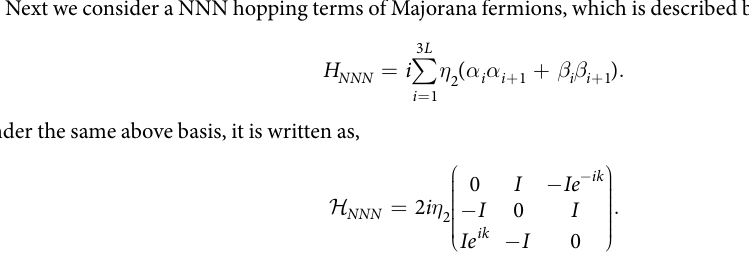
 = P reduction of the topological invariant from Z to Z 2 is due to the NNN hopping terms. It gaps every two Majorana zero modes, thus the cases with even (odd) number of Majorana zero modes become identical and the topological invariant changes to Z 2 integer. To be specific, we plot the open energy spectrums with the symmetry breaking terms. In Fig. 5(a) we start from a topological phase with two α and one β Majorana zero modes at each end, when there are six zero-energy modes. After adding the NN hopping term, one α and one β Majorana zero modes at each end are gapped and only one pair of Majorana zero modes remain. In Fig. 5(b) we start from a topological phase with two α Majorana zero modes at each end. After adding the NNN hopping term, they are gapped. The results are consistent with our previous analysis. The NN and NNN hopping terms gap every two Majorana zero modes and at most one Majorana zero mode persists on each end. So the topological invariant is reduced from Z to Z 2 , which corre- sponds to the change of the topological class from BDI to D. Thus we present an intuitive explanation of the Z 2 nature of the topological invariant in the D class.